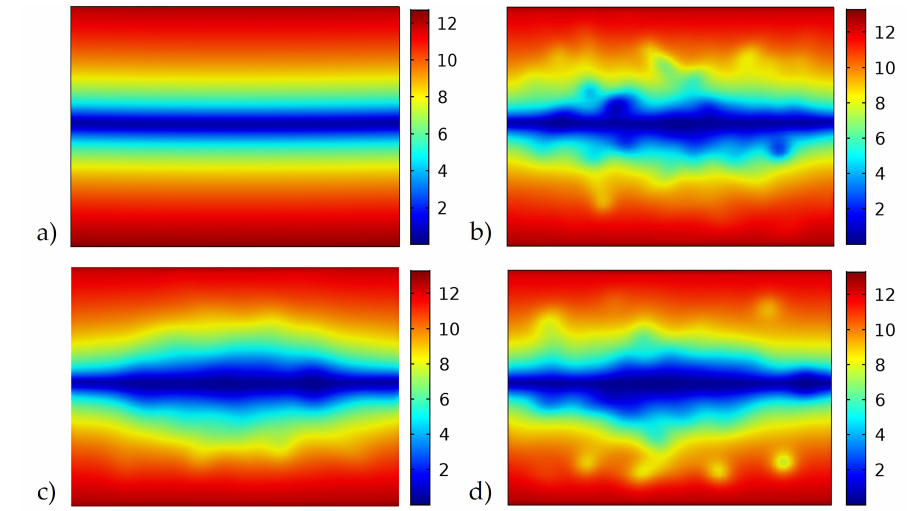
Figure 11. Core von-Mises stress at mid-point for each four-point bend simulation in the units of MPa for ( a ) uniform core, ( b ) sample 1, ( c ) sample 2, and ( d ) sample 3.